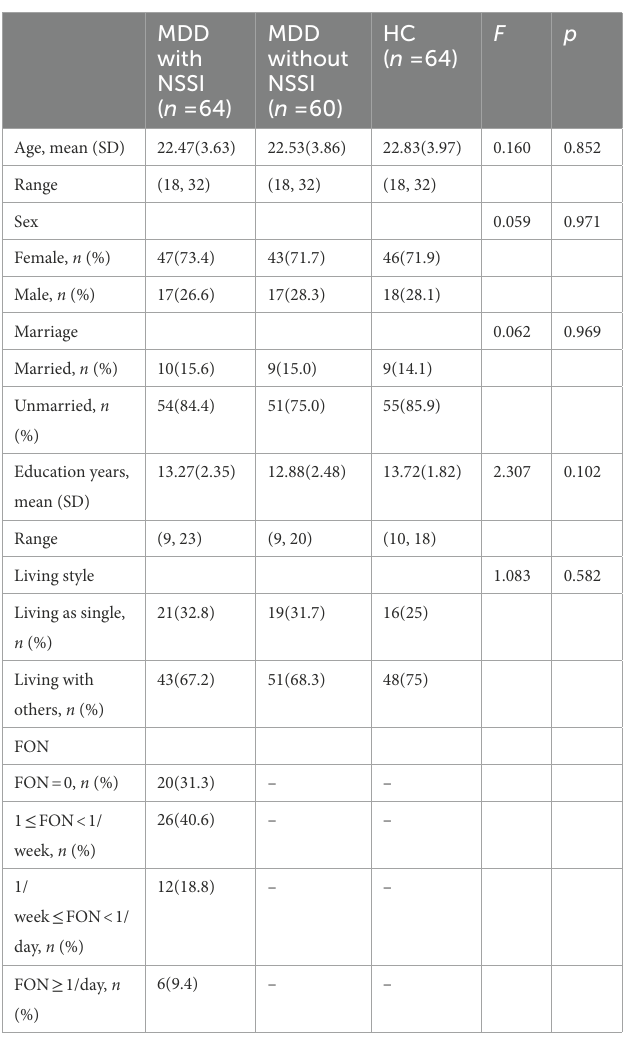
TABLE 1 Demographic, clinical characteristics of subjects and the frequency of non-suicidal self-injury (NSSI) last month in depressive disorder patients (MDD) with NSSI